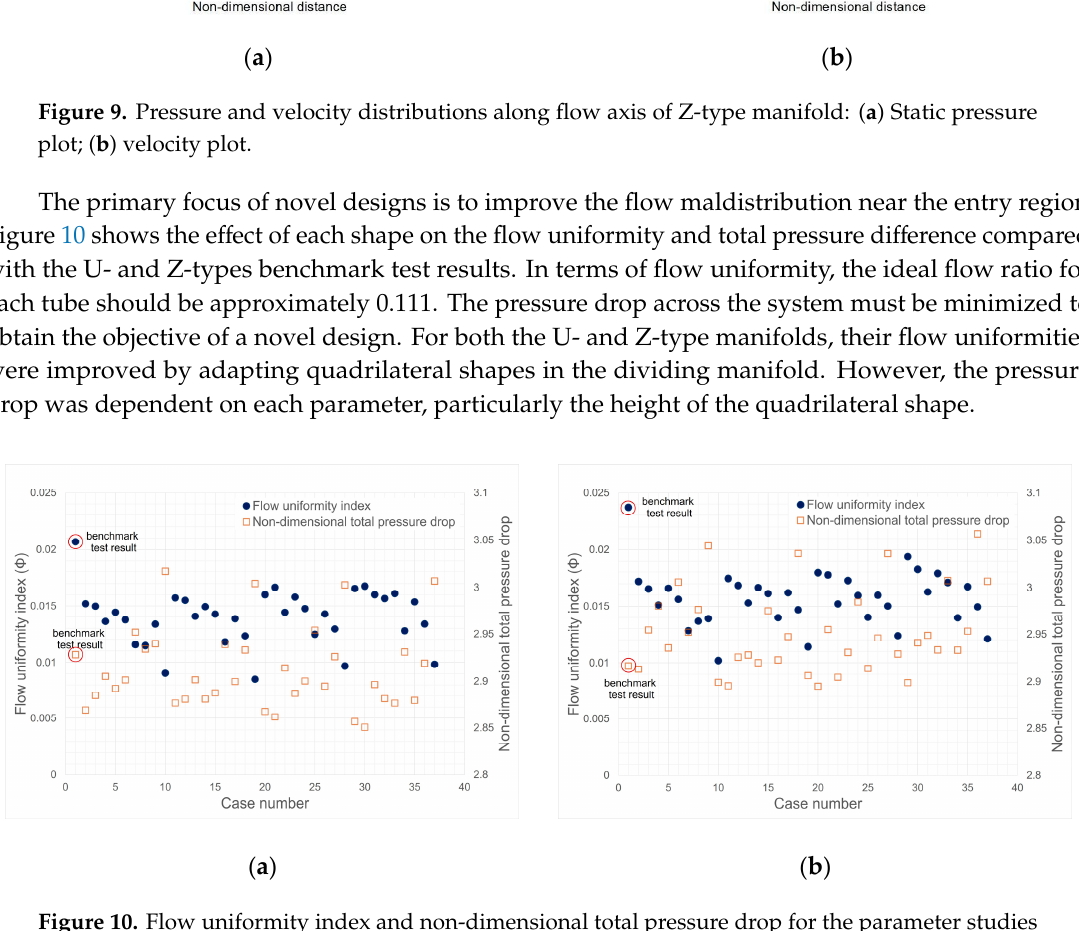
Figure 9. Pressure and velocity distributions along flow axis of Z-type manifold: ( a ) Static pressure plot; ( b ) velocity plot.